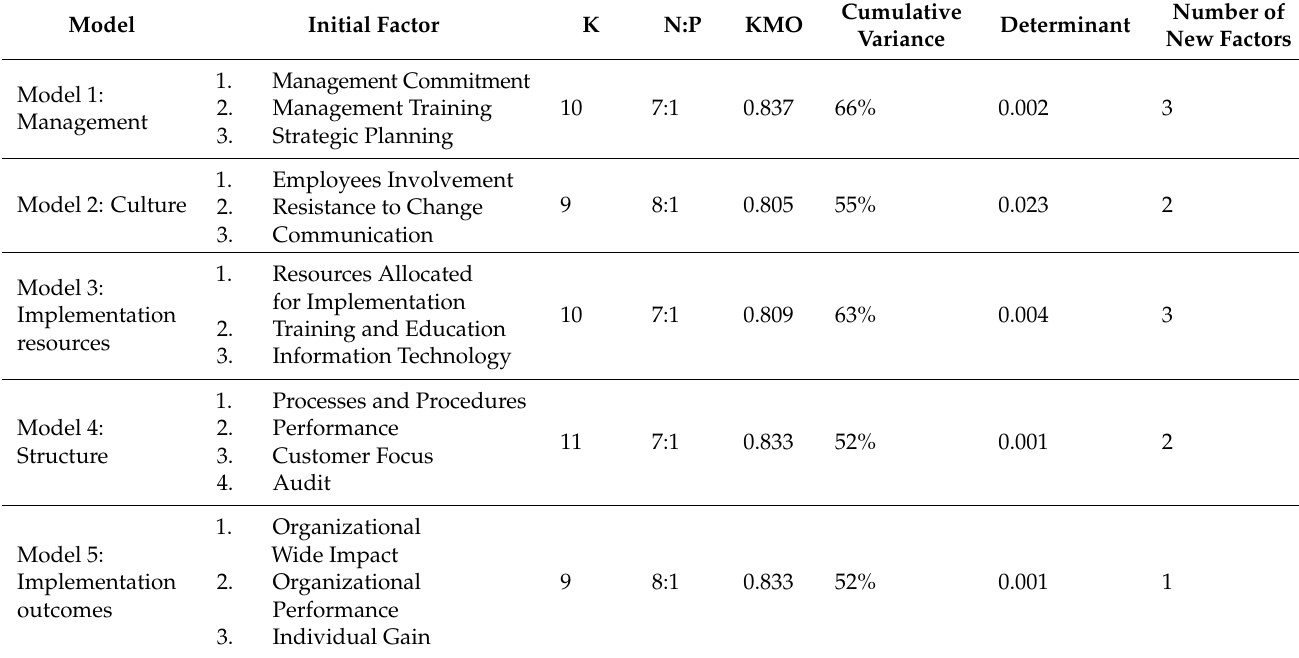
Table 4. EFA fit of emergent factors